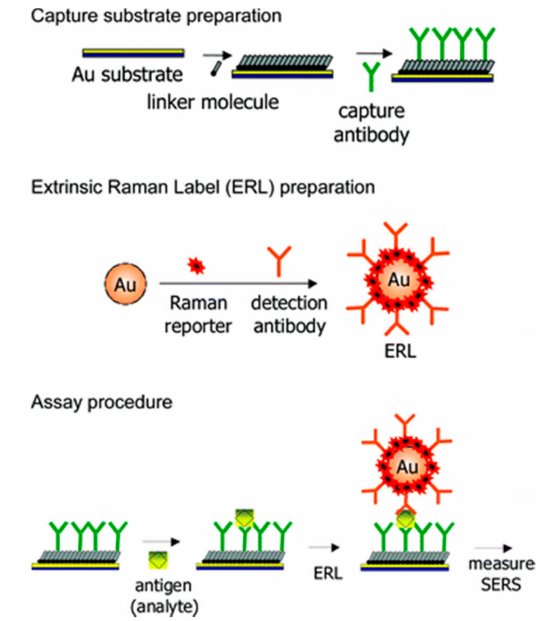
Figure 4. SERS-based immunoassay platform [35]. Antibodies were fixed on a platform to capture antigen, Ag or Au NPs conjugated with both Raman tags and detection antibodies can then be captured for SERS